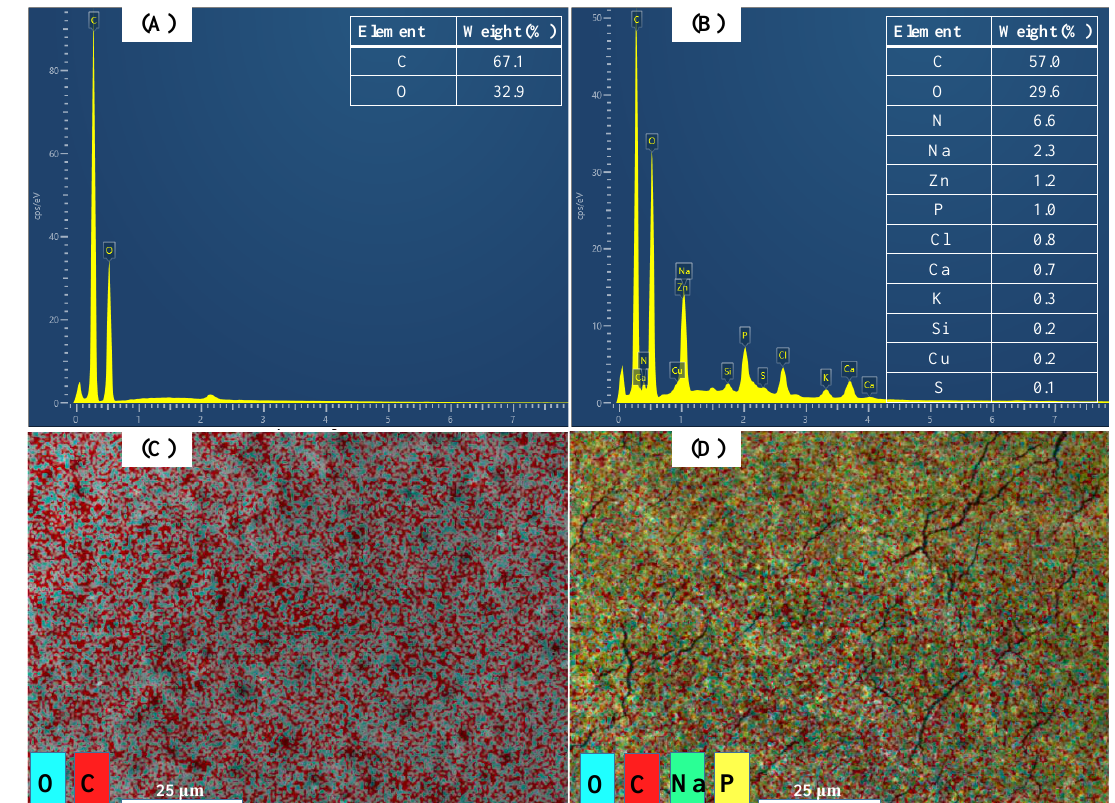
Figure 5. Point and face scan for EDS measurements of the active layer of the pristine membrane ( A , C ) and fouled membrane ( B , D ) after concentrating biogas slurry. The fouled membrane is denoted in Figure 4.